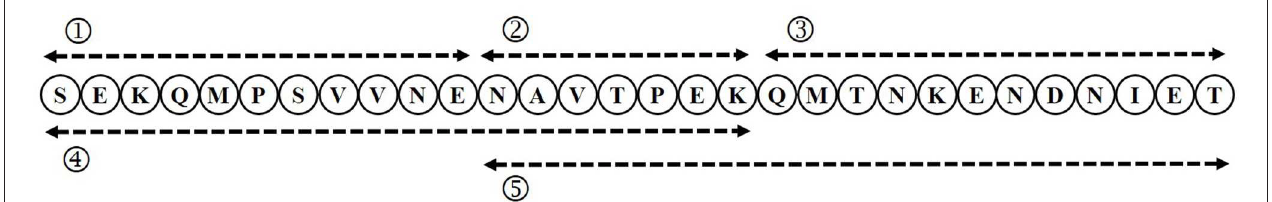
FIGURE 2 | Schematic of truncated peptides.